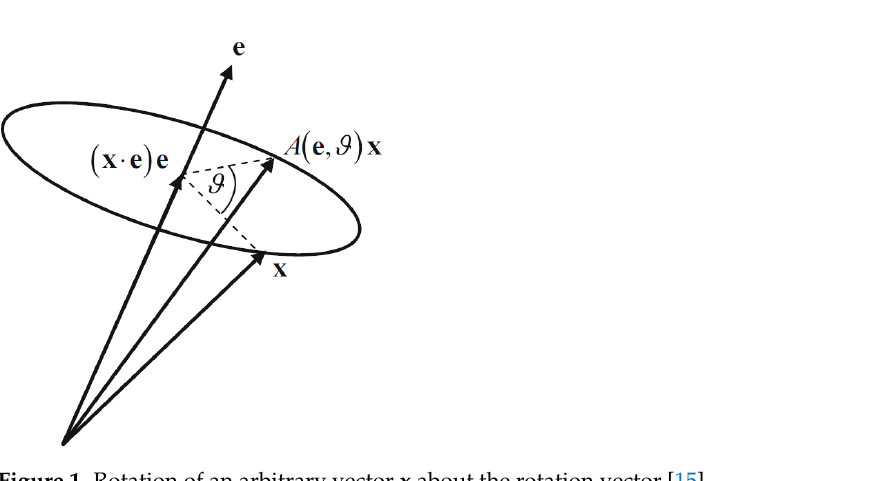
Figure 1. Rotation of an arbitrary vector x about the rotation vector